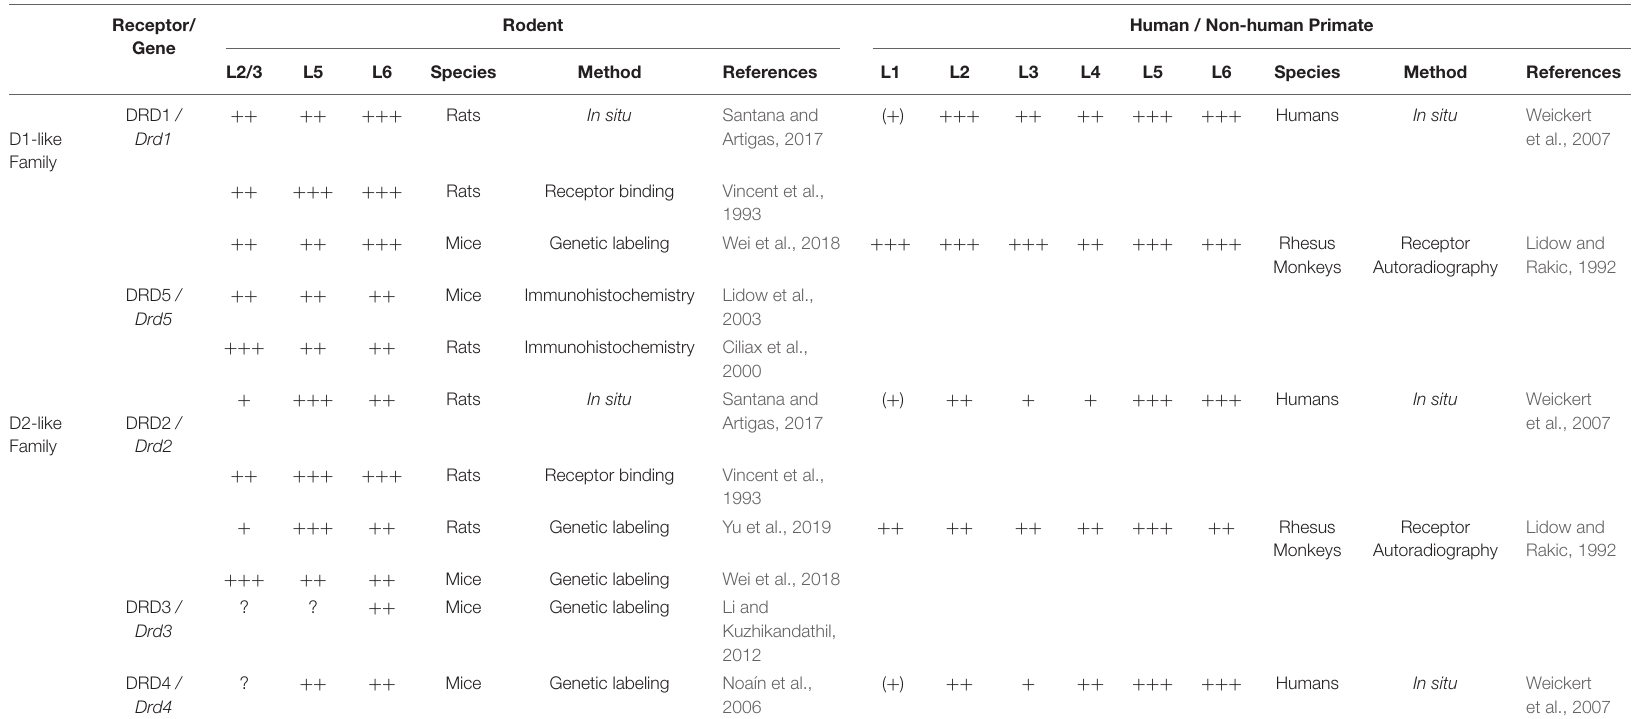
TABLE 1 | Laminar distribution of Drds /DRDs in the PFC of rodent, rhesus monkey and